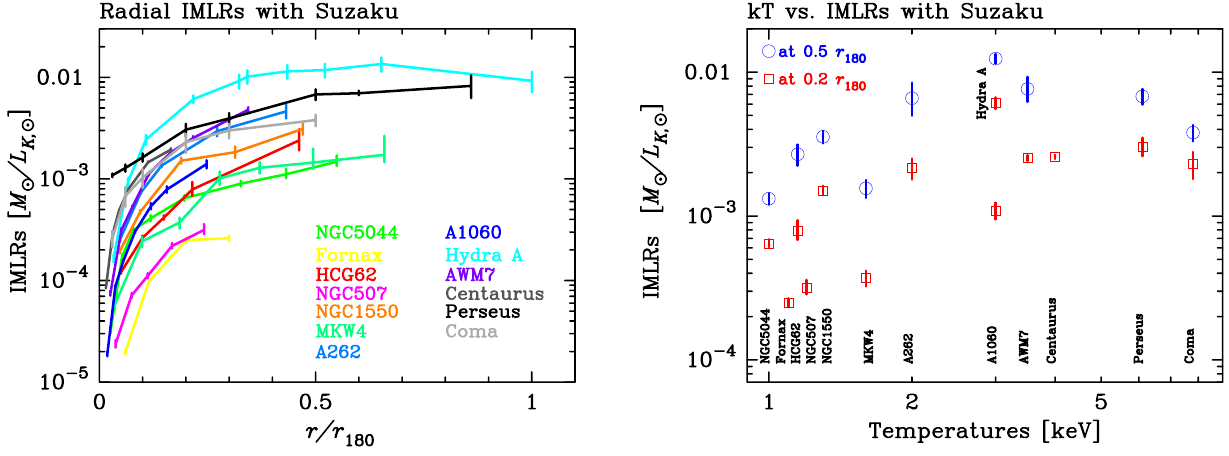
Figure 8. ( Left ) Radial IMLR profiles with Suzaku X-ray observations and K-band luminosity of the member galaxies from 2MASS data [75,120,121,189–191]. ( Right ) Temperature dependence of the IMLRs for groups and clusters in 0.2 or 0.5 r 180 with